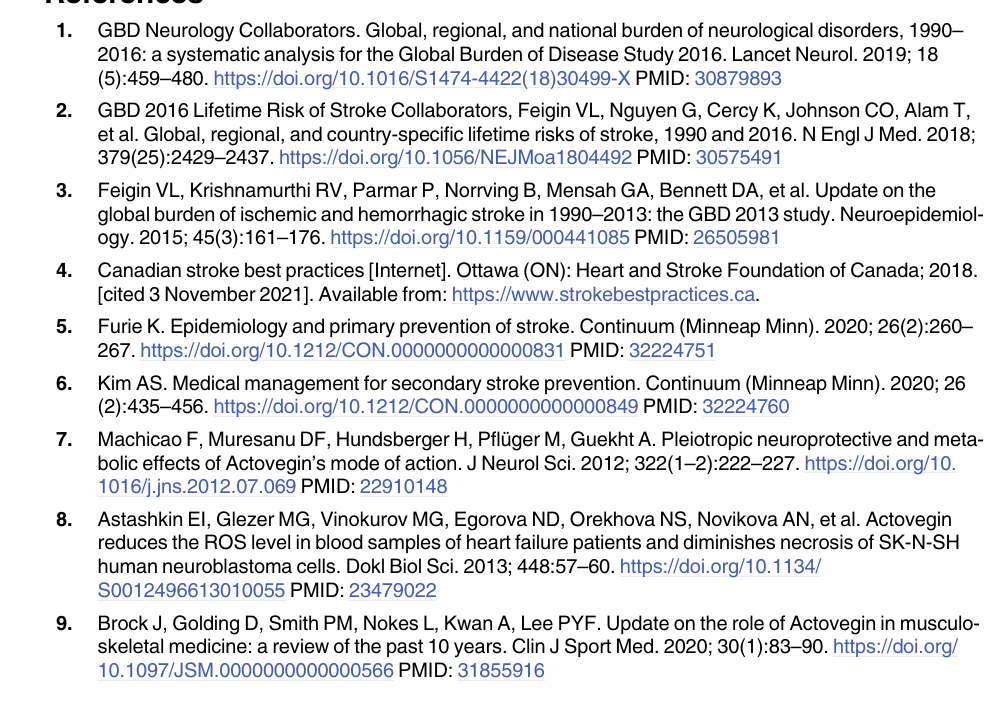
S1 Table. Literature Search Strategy. S2 Table. PRISMA 2020 for Abstract Checklist. S3 Table. PRISMA 2020